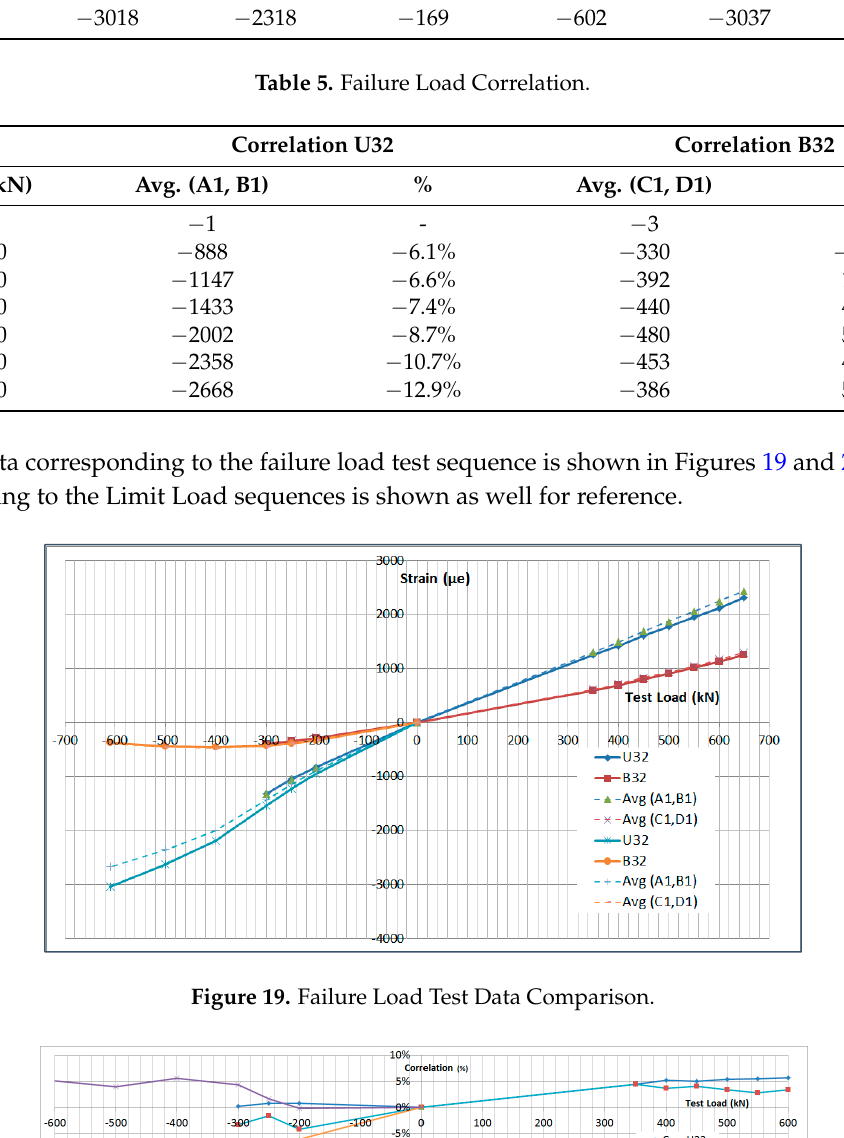
Table 4. Failure Load Test Data.